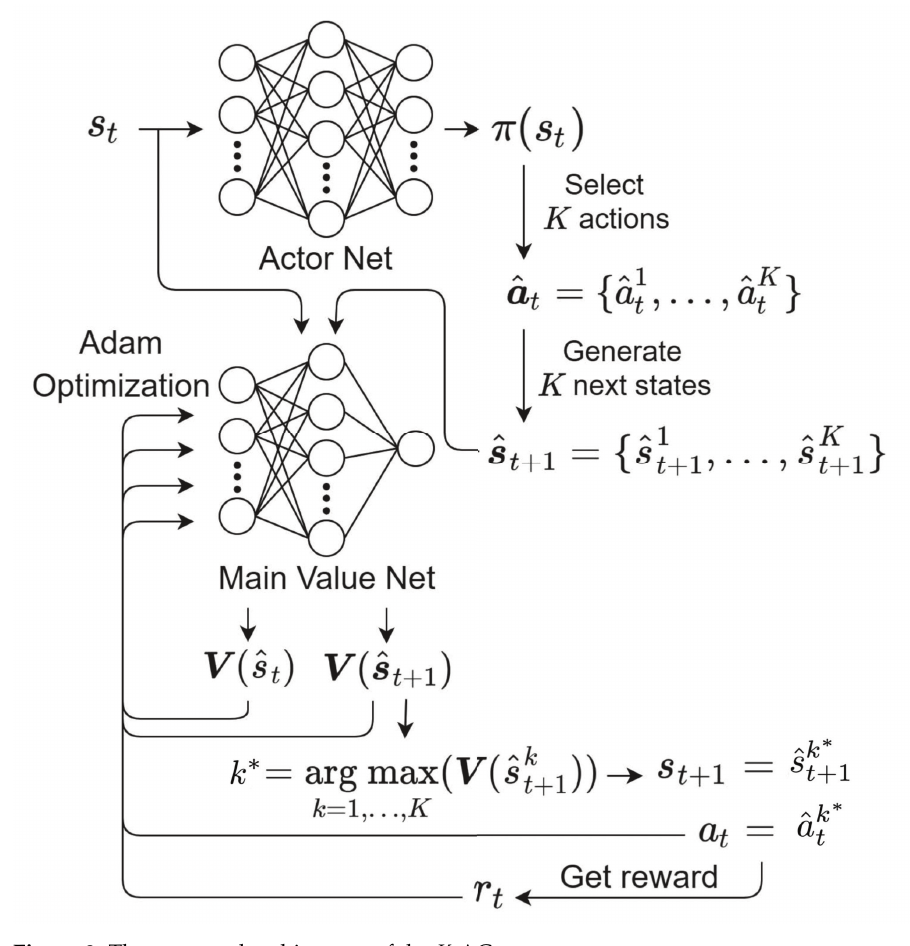
Figure 3. The proposed architecture of the K -AC.